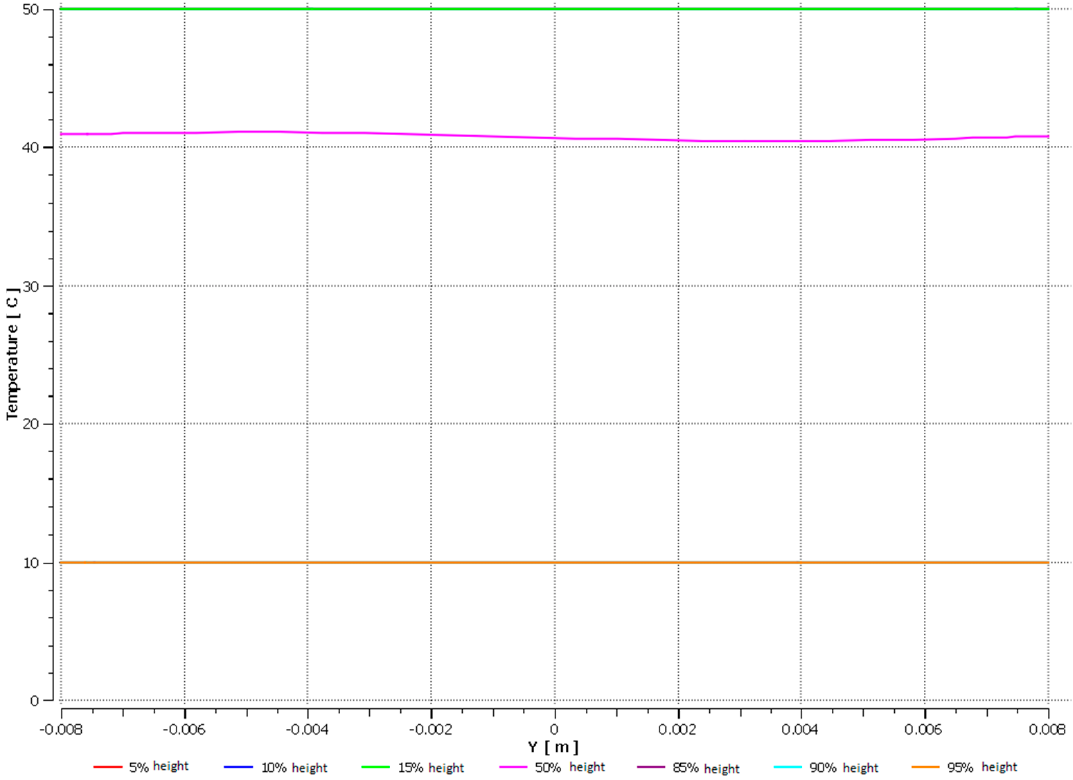
Figure 5. Temperature distribution along the cross-section.